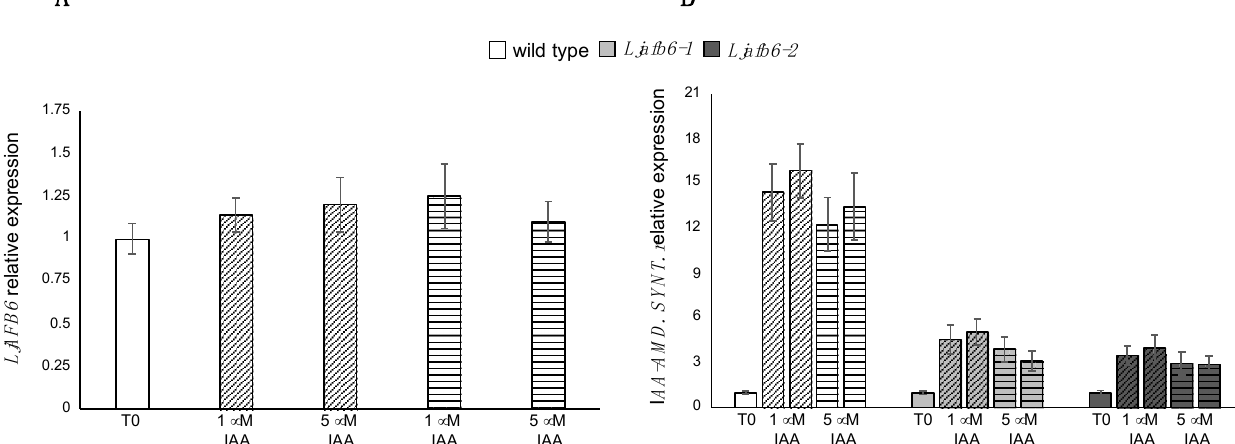
Figure 9. Auxin responsive profiles of expression. ( A ) Wild type plants were treated with 1 and 5 µ M IAA for 12 and 24 h. ( B ) Wild type and Ljafb6 plants were treated with 1 and 5 µ M IAA for 12 and 24 h. Genotypes and growth conditions are indicated. Bars with oblique and horizontal motifs indicate 12 h and 24 h samples, respectively. RNAs were extracted from roots and qRT-PCR performed using primers listed in Table S2. Expression levels were normalized with respect to the internal control UBIQUITIN ( UBI ) gene and plotted relative to the expression of T0. Data bars represent means and SD of data obtained with RNA extracted from three different sets of plants and three qRT-PCR experiments.